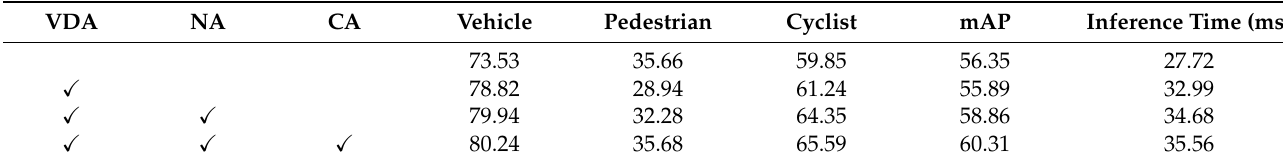
Table 4. Ablation study on ONCE validation